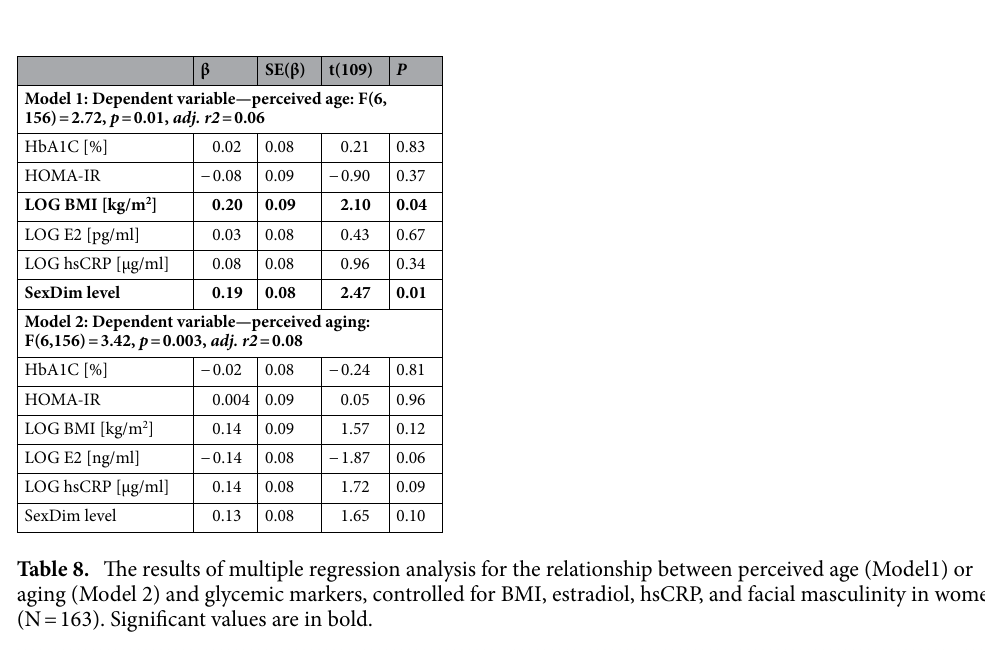
Table 7. The results of multiple regression analysis for the relationship between perceived age (Model1) or aging (Model 2) and glycemic markers, controlled for BMI, cortisol, hsCRP and facial masculinity in men (N = 116). Significant values are in bold.